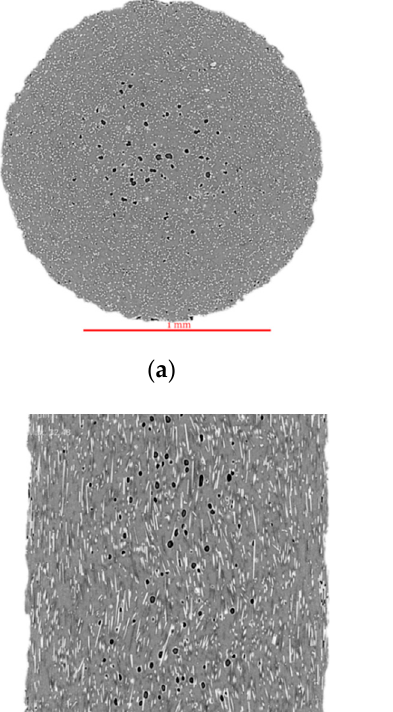
Table 2. Specifications of fiber filament. Information Provided